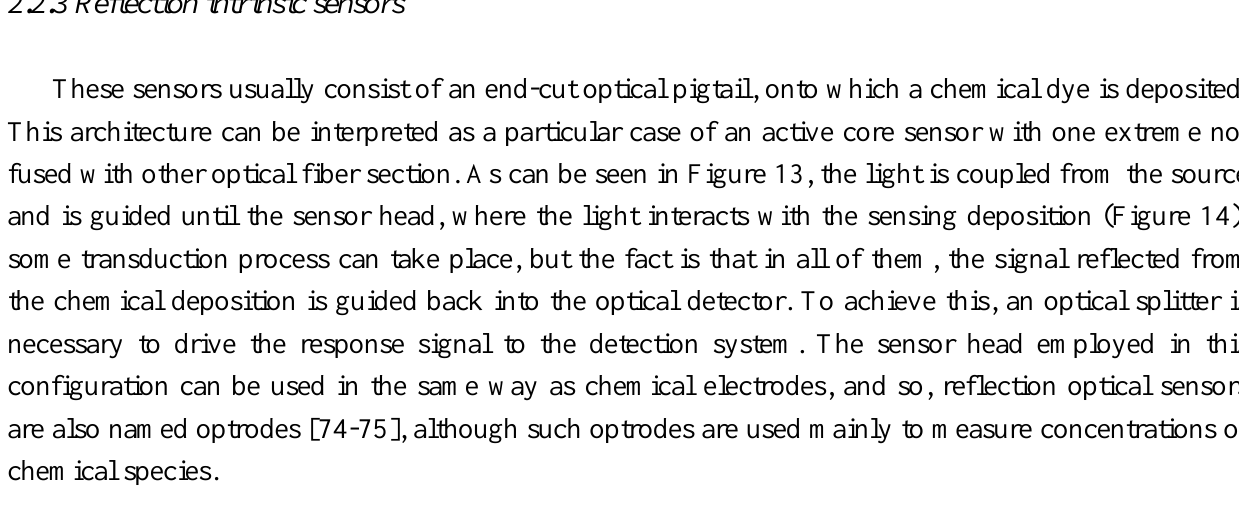
Figure 13 . Reflection experimental set